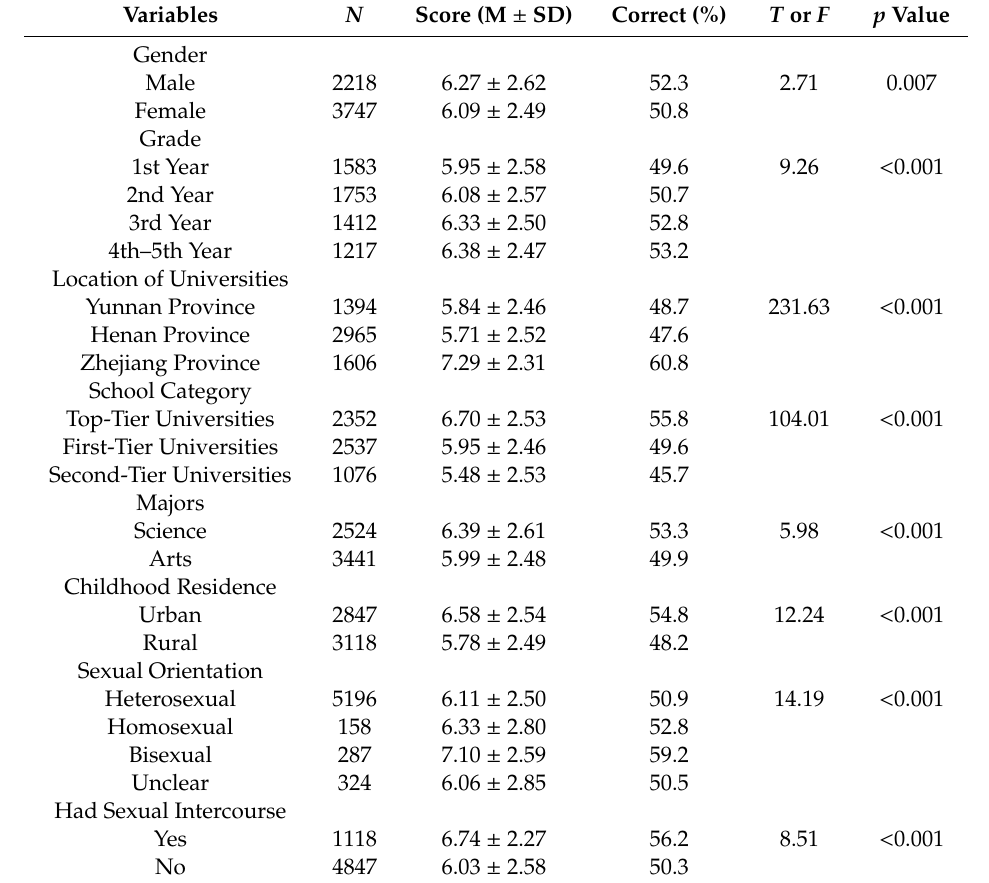
Table 4. Factors associations with sex-related knowledge among Chinese university students.